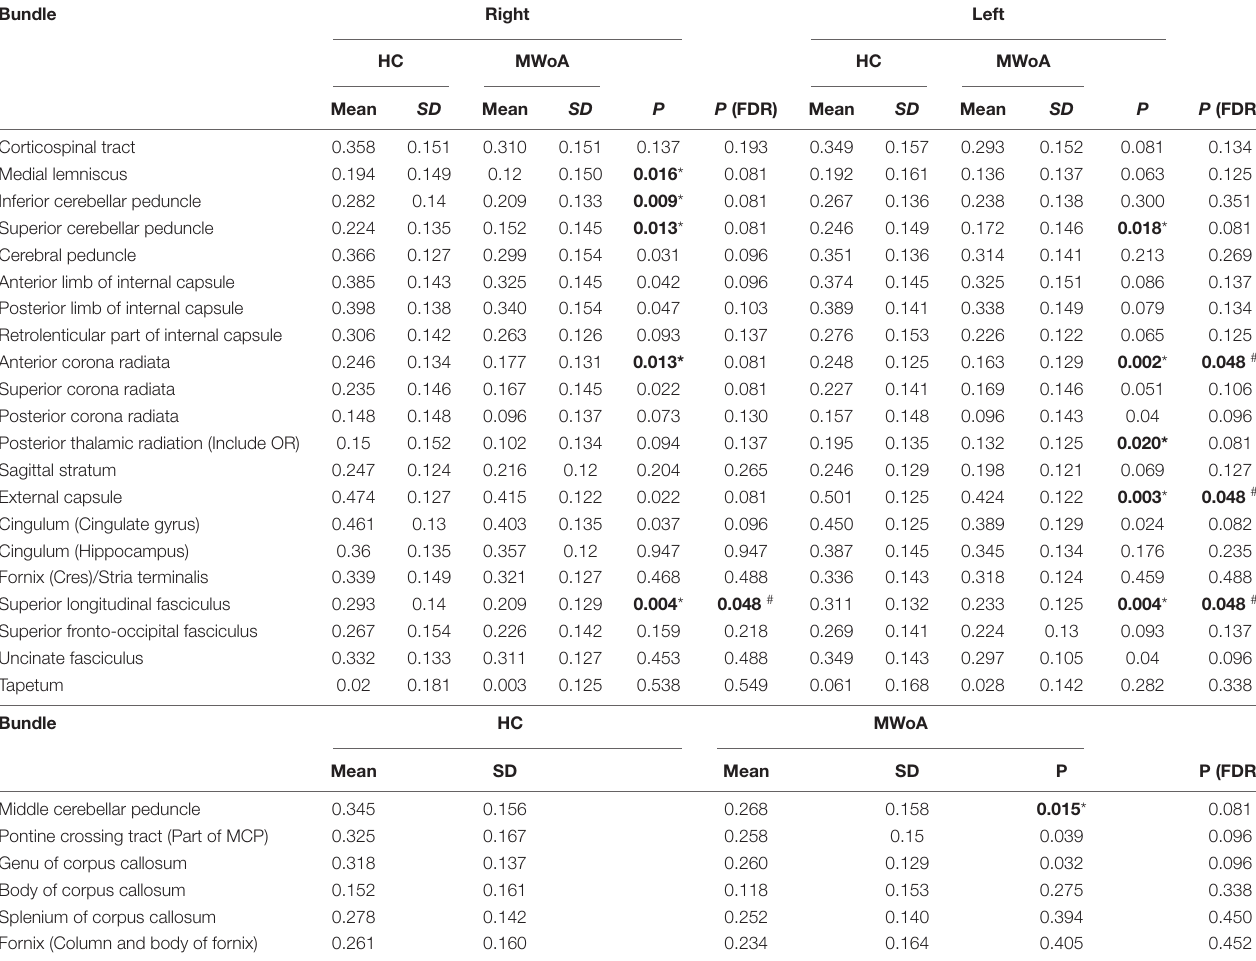
TABLE 2 | Summary of t -tests of GM-averaged correlation coefficients of WM bundles in migraine without aura (MWoA) compared to healthy controls (HC). Bundle